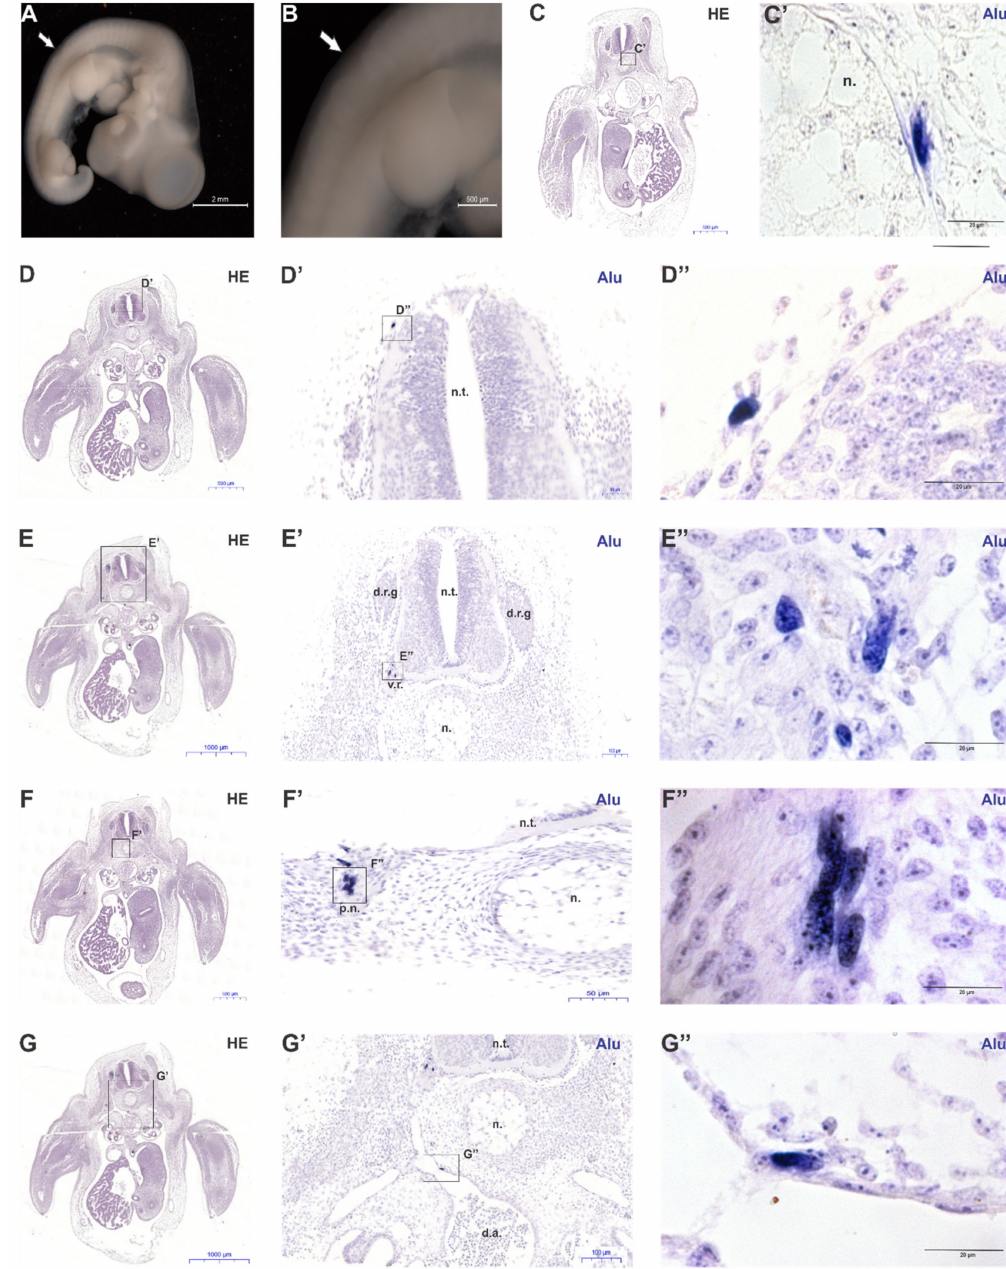
Figure 3. In vivo migration capacity of mbMSC during embryo development. ( A , B ) Representative photomicrographs of a E4.5-5 chick embryo after spheroid implantation. White arrows indicate a scar in the somatic region, where the engraftment was performed. ( C – G ) Hematoxylin and eosin staining of cross sections at the wing level. ( C’ – G’ , C” – G” ) Sections adjacent to ( C – G ) counterstained with hematoxylin and hybridized with Alu probes. ( C’ ) Presence of Alu -positive mbMSC lateral to the notochord, in presumptive chondrogenic regions. ( D’ – D” and E’ – E” ) Alu -positive mbMSC were close to the basal lamina of the neural tube and ventral root, respectively. ( F’ , F” ) Alu -positive mbMSC were associated with developing peripheral nerves. ( G’ , G” ) Presence of Alu -positive mbMSC in direct contact with the dorsal aorta endothelium of the chick embryo. All scale bars are indicated in the images. N.t., neural tube. d.a., dorsal aorta. n., notochord. d.r.g., dorsal root ganglion. v.r., ventral root. p.n.: peripheral